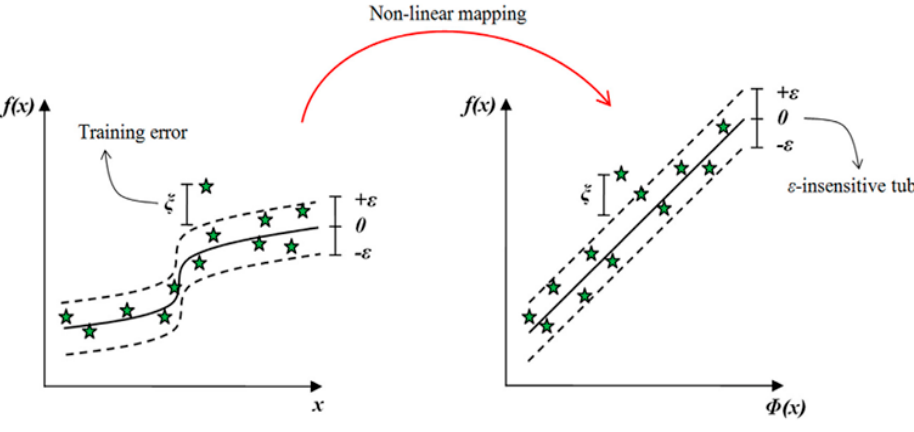
Figure 6. The concept of the ε -insensitive loss function.